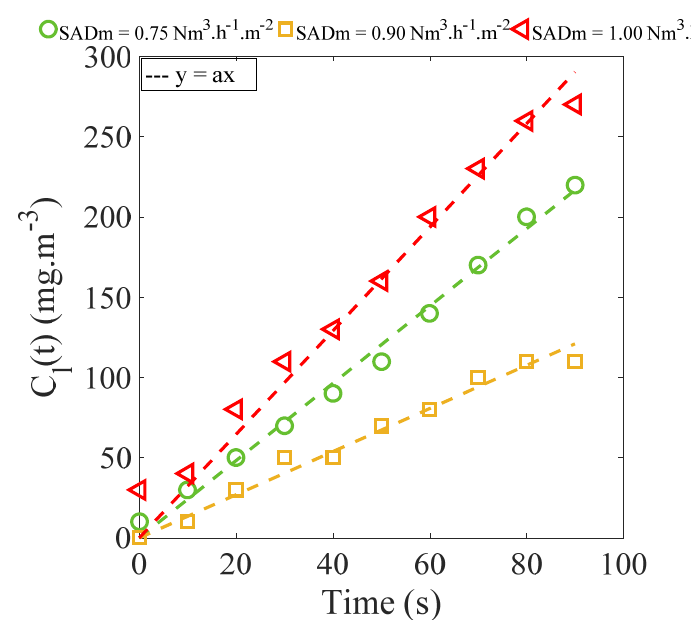
Figure 8. Initial evolution (over the first 90 s) of the concentration of Rose Bengal lactone in the liquid phase, using beads with three air flowrates. ALMBR experiments.